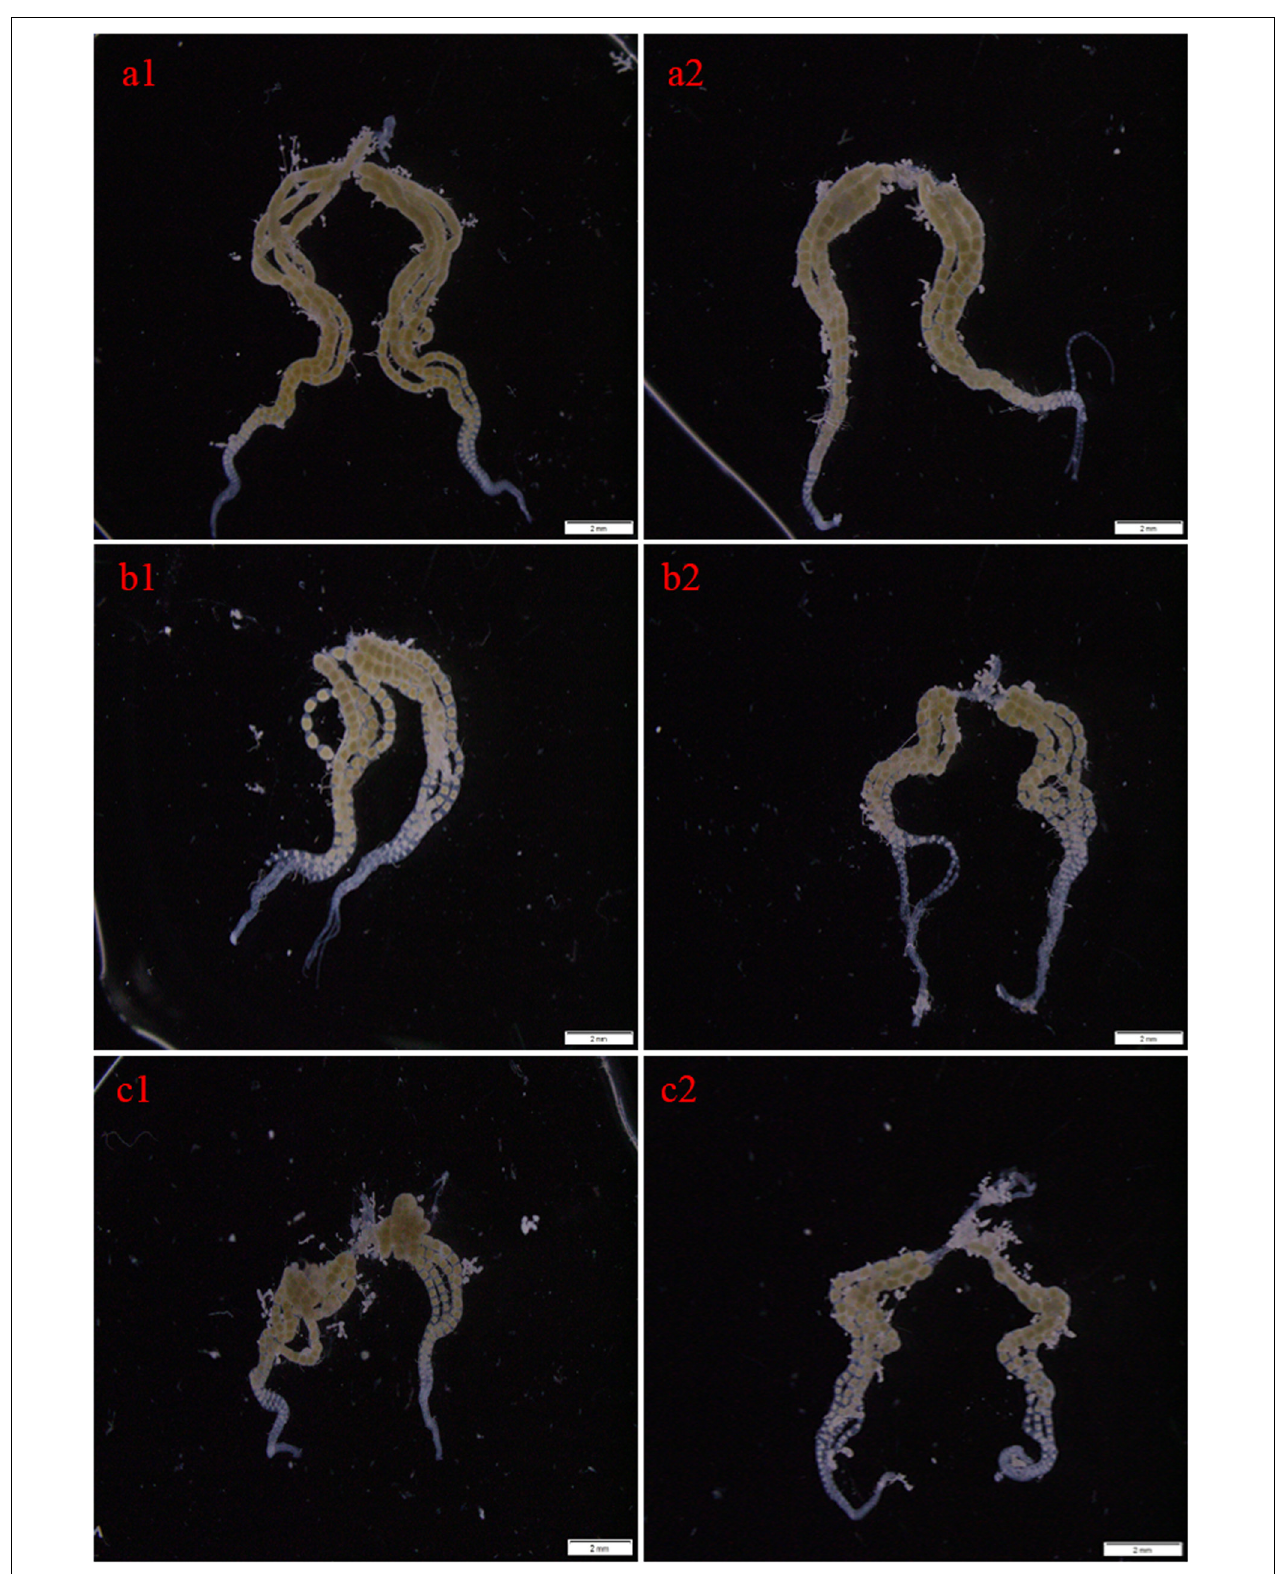
FIGURE 6 | Effects of RNAi-mediated knockdown of CsMet1 and CsMet2 on ovary development with dsEGFP as a control. The ovaries were dissected from female adults at 24 h after the second injection of dsEGFP (a1, a2), dsCsMet1 (b1, b2) and dsCsMet2 (c1, c2).